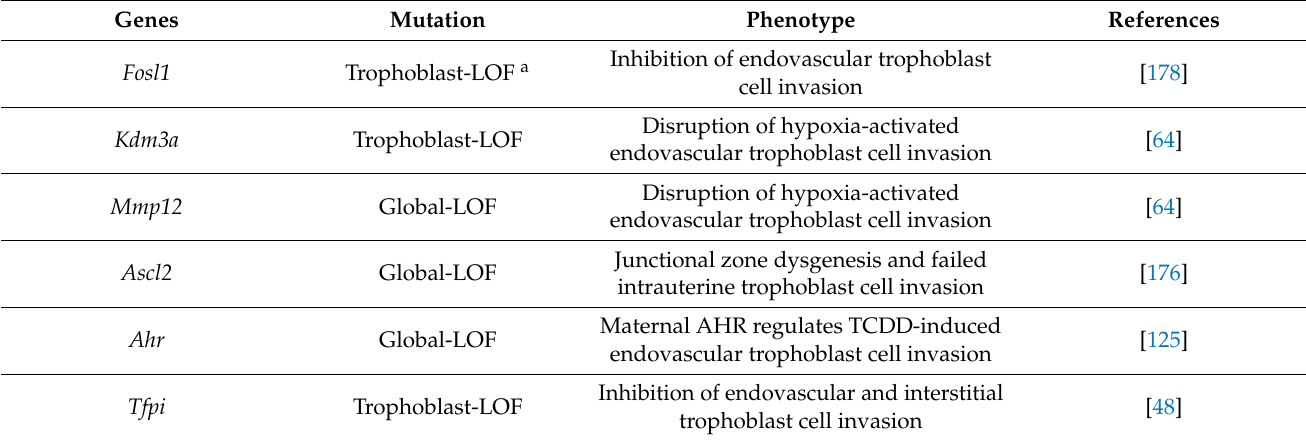
Table 2. Regulatory genes affecting the rat uterine-placental